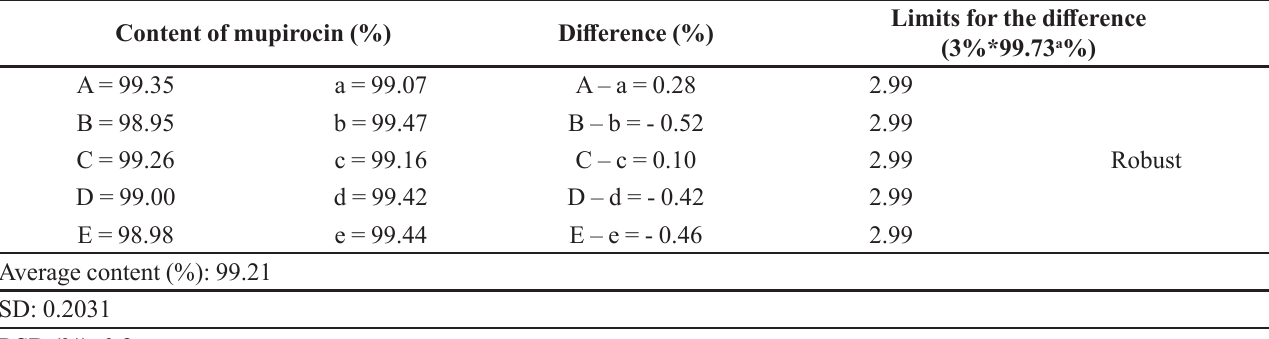
TABLE V - Combinations tested to evaluate the robustness, evaluating condition 2 Content of mupirocin (%)